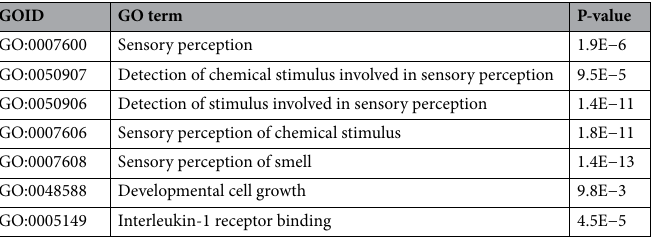
Table 3. Summary of the results from the ontology of genes identified in CNV regions in all samples.